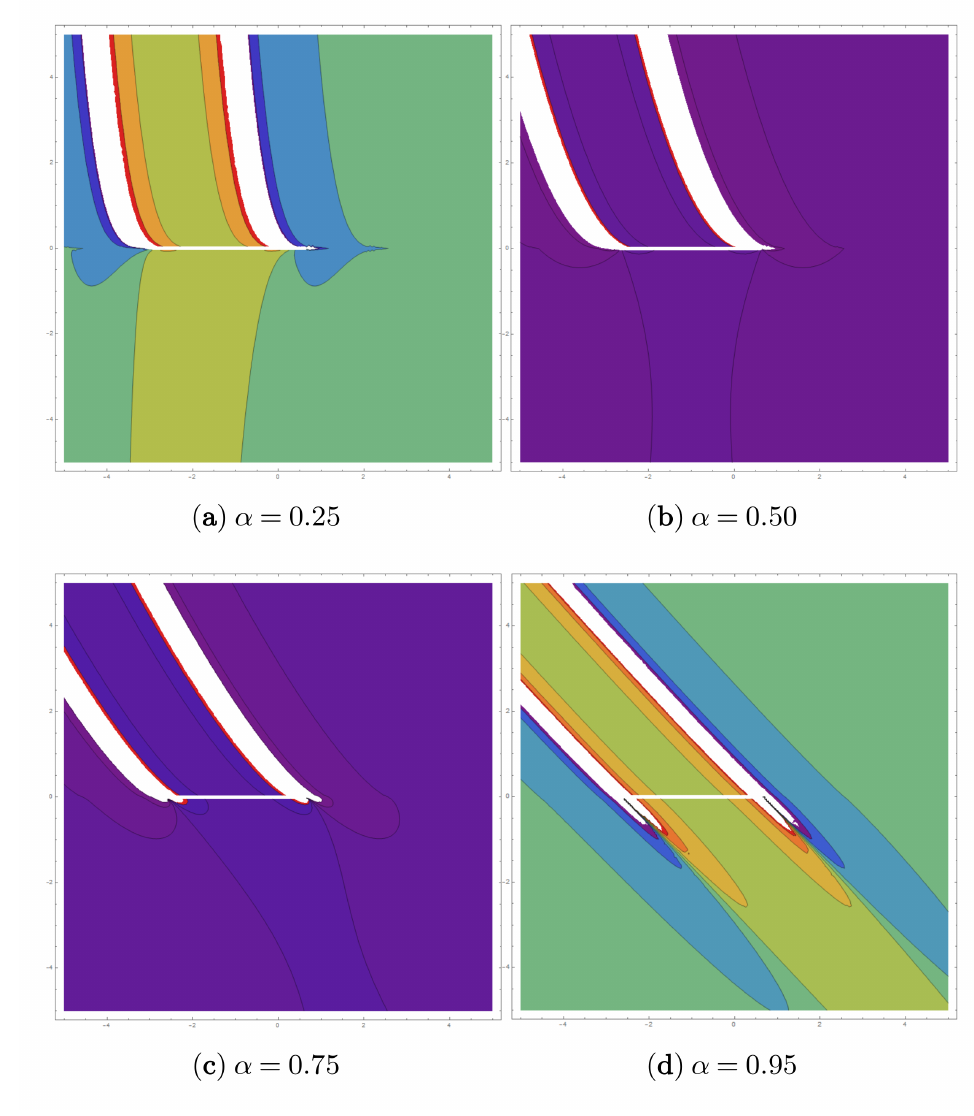
Figure 13. The 2D-contour graphs for S 11